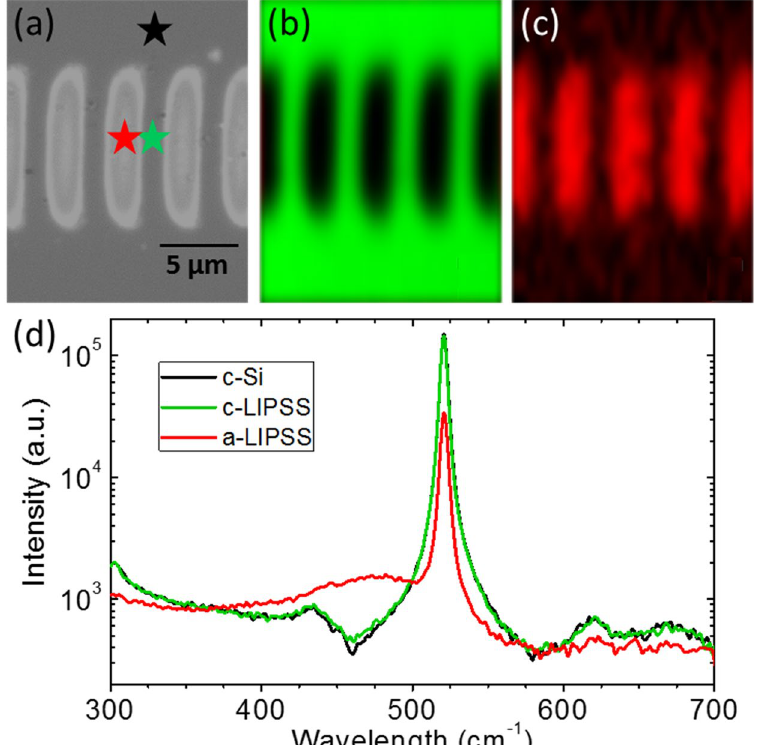
Figure 4. Raman spectroscopy of long-period amorphous fringes ( Λ s + LIPSS). ( a ) Optical micrograph of the studied region. The symbols mark the positions at which the point measurements shown in ( d ) were performed. ( b ) Map of the signal amplitude of the Raman band of c-Si centered at 520.5 cm − 1 . ( c ) Map of the signal amplitude of the Raman band of a-Si at 473 cm − 1 . ( d ) Raman spectra recorded at the positions marked in ( a